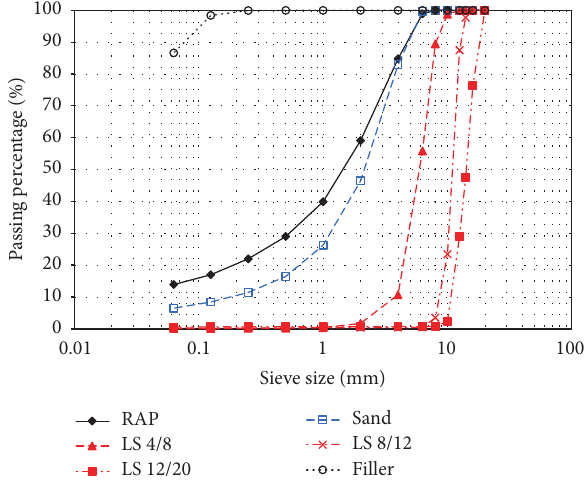
Figure 1: Grading curves of the